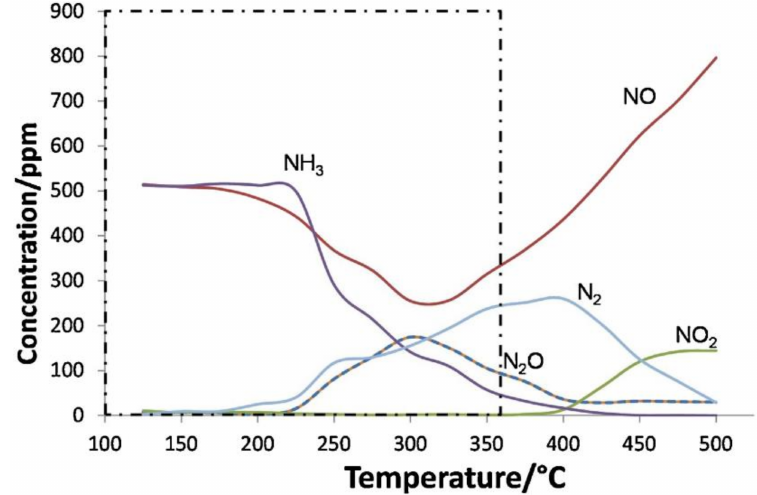
Figure 1. NOx reduction over K-free Ag/CZA using NH 3 as reductant. Dotted line indicates typical ‘temperature window’ for diesel exhaust emitted by passenger cars. This figure was published in Applied Catalysis B , 239, Davies et al., Simultaneous removal of NOx and soot particulate from diesel exhaust by in-situ catalytic generation and utilisation of N 2 O [13]. 2018, Elsevier.